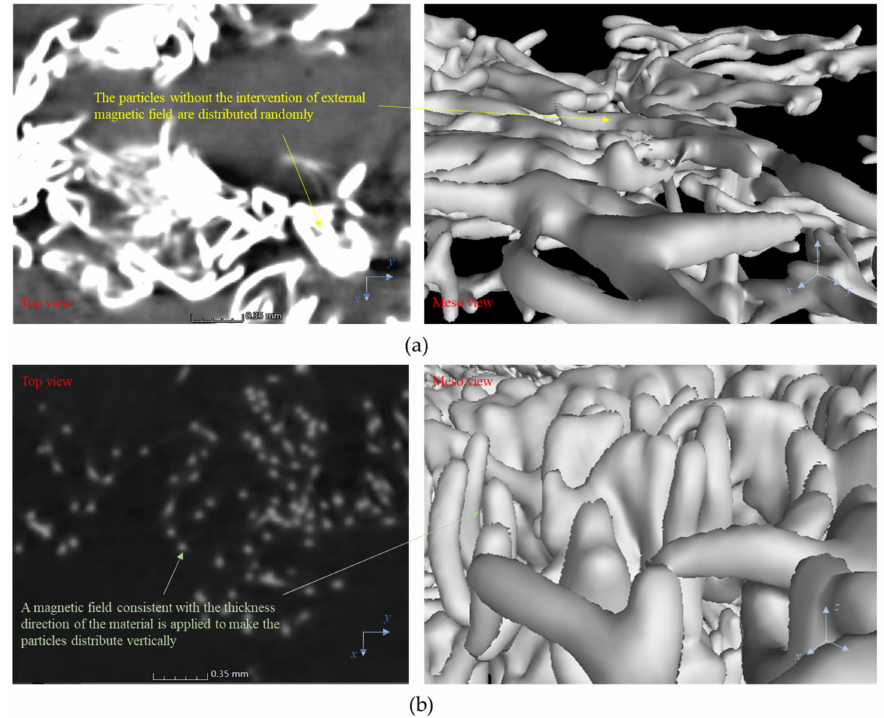
Figure 2. Comparison of micro particle distribution diagram of ( a ) SJ and ( b ) SZ